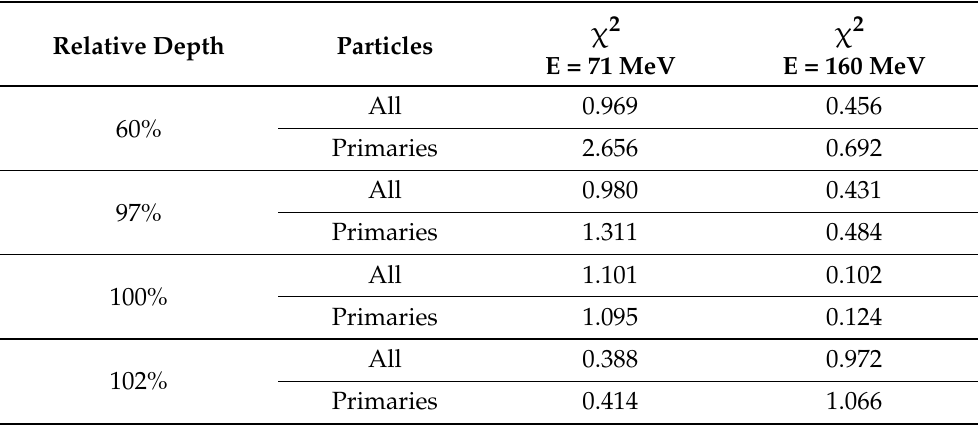
Table A1. Reduced Chi square test values comparing experimental survival data from Howard et al. [11] and predicted values of this work considering all particles and only protons in the case of an initial energy beam of 71 MeV and 160 MeV. The plots reporting the models and the experimental data are respectively Figures 7 and